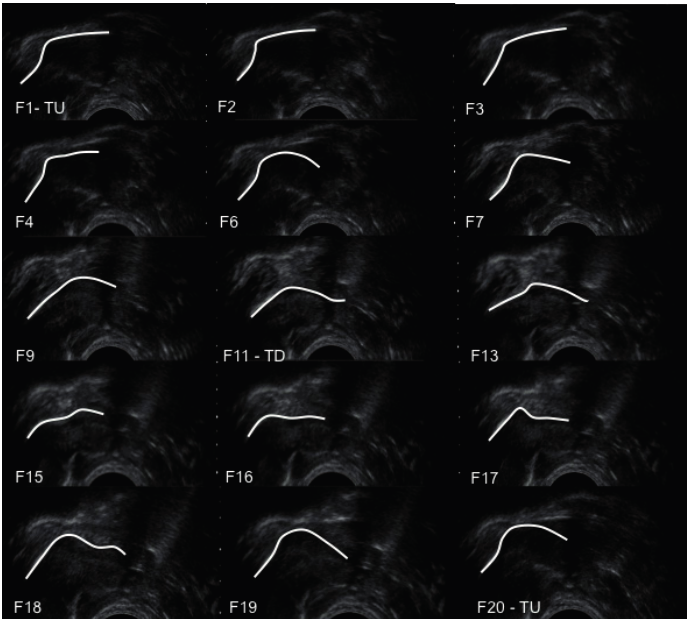
Figure 2. Sequential submental ultrasound frames (F1 to F20) of the infant intra-oral cavity with the tongue contour marked in white. TU, tongue up; TD, tongue down.